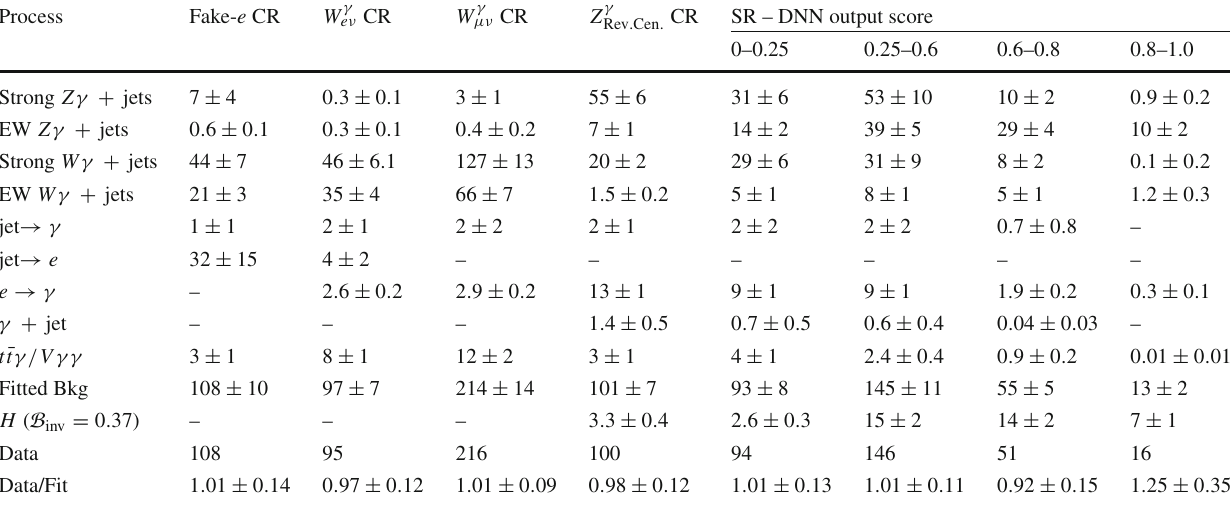
atic uncertainties; as a result, the uncertainties in the total background can be smaller than the sum of those in the single contributions. The predicted signal yields, assuming a 37% branching ratio for H → inv . are shown with their associated uncertainties. A dash ‘–’ indicates less than 0.01 events